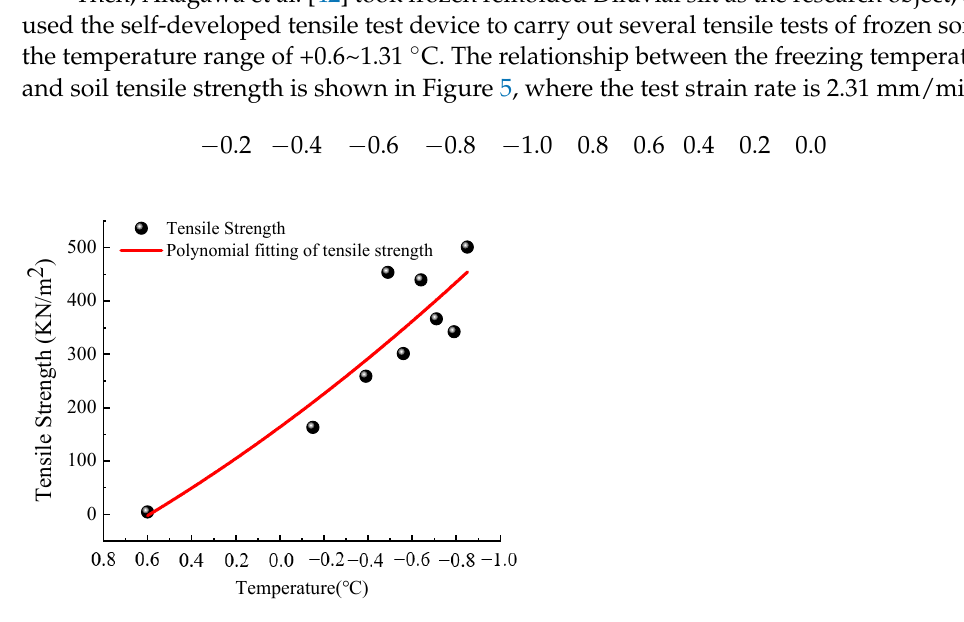
Table 3. Relationship between the tensile strength of soil in the frozen fringe and freezing temper- ature.